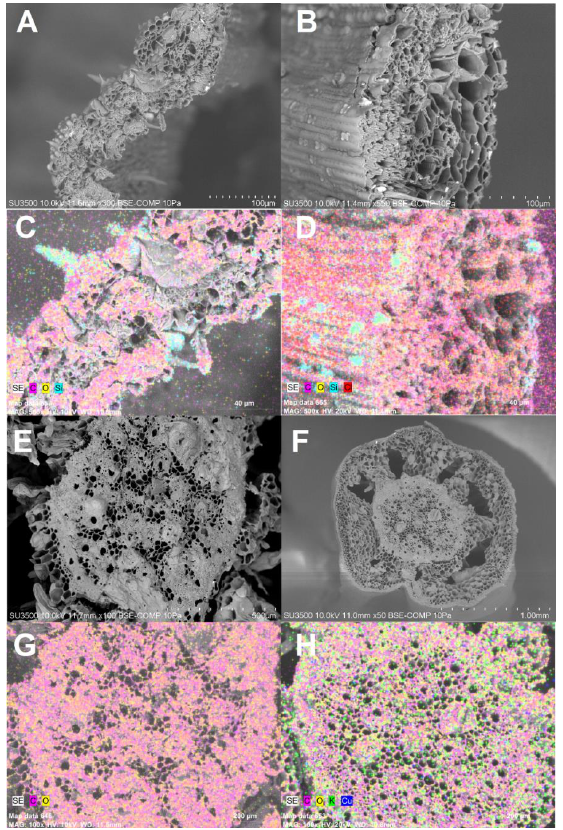
Figure 3. Scanning electron microscopy (SEM) and energy-dispersive x-ray (EDX) analysis of Imperata cylindrica after 21 days of growth. ( A ) Transverse cutting of shoot under control condition, and ( B ) Transverse cutting of shoot under stress condition (300 mg Cu kg − 1 substrate). ( E ) Transverse cutting of root (rhizome) under control condition, and ( F ) Transverse cutting of root (rhizome) under stress condition (300 mg Cu kg − 1 substrate). Elemental localization by EDX analysis: ( C ) Transverse cutting of shoot under control condition, and ( D ) Transverse cutting of shoot under stress condition (300 mg Cu kg − 1 substrate). ( G ) Transverse cutting of root (rhizome) under control condition, and ( H ) Transverse cutting of root (rhizome) under stress condition (300 mg Cu kg − 1